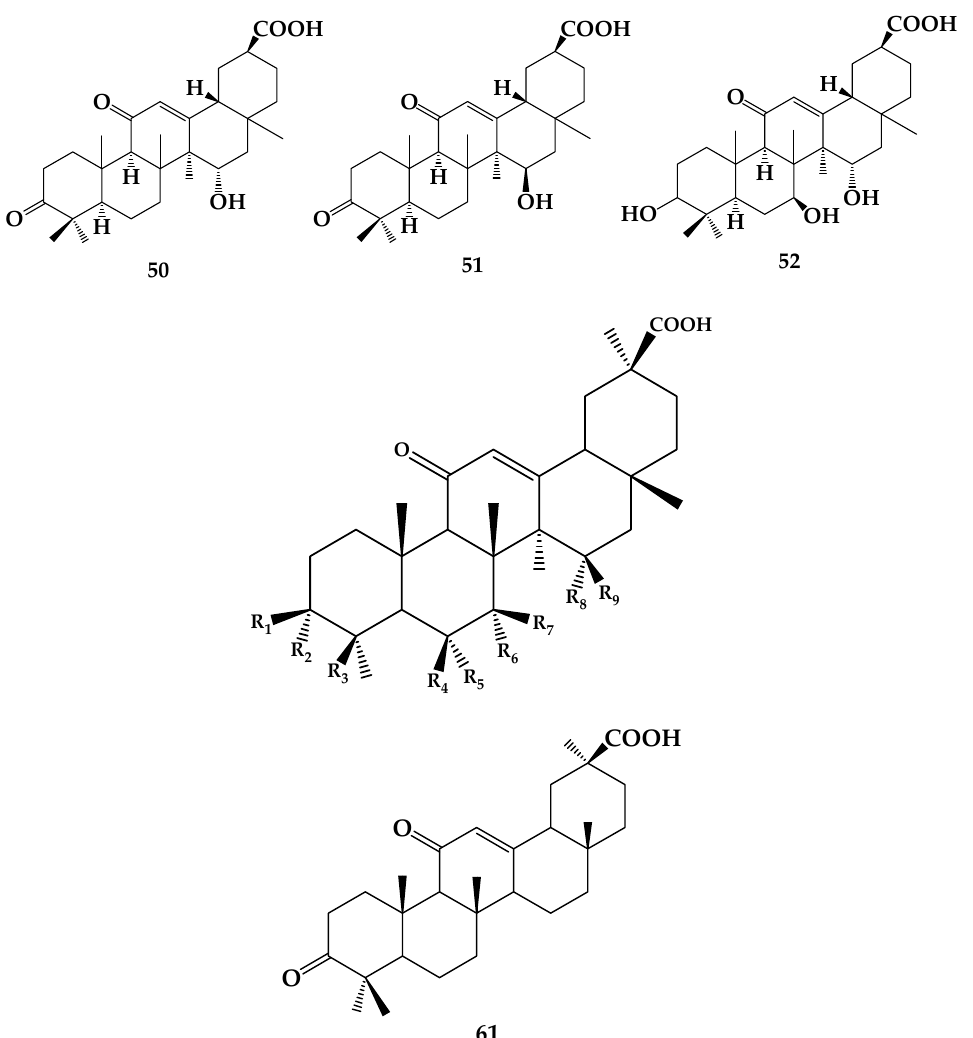
Figure 11. The chemical structures of compound 50–61